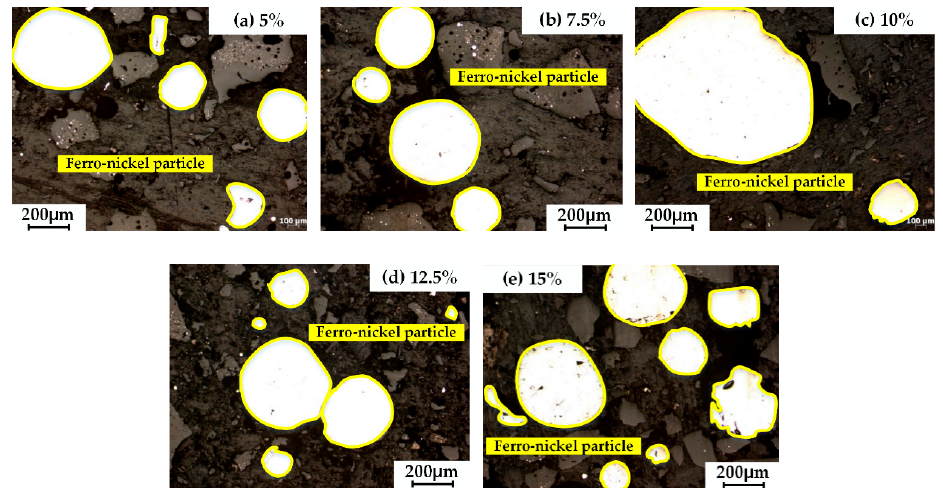
Figure 12. Optical microscope images of ferro-nickel particles under different CaO additions: ( a ) 5%; ( b ) 7.5%; ( c ) 10%; ( d ) 12.5%; ( e ) 15%.